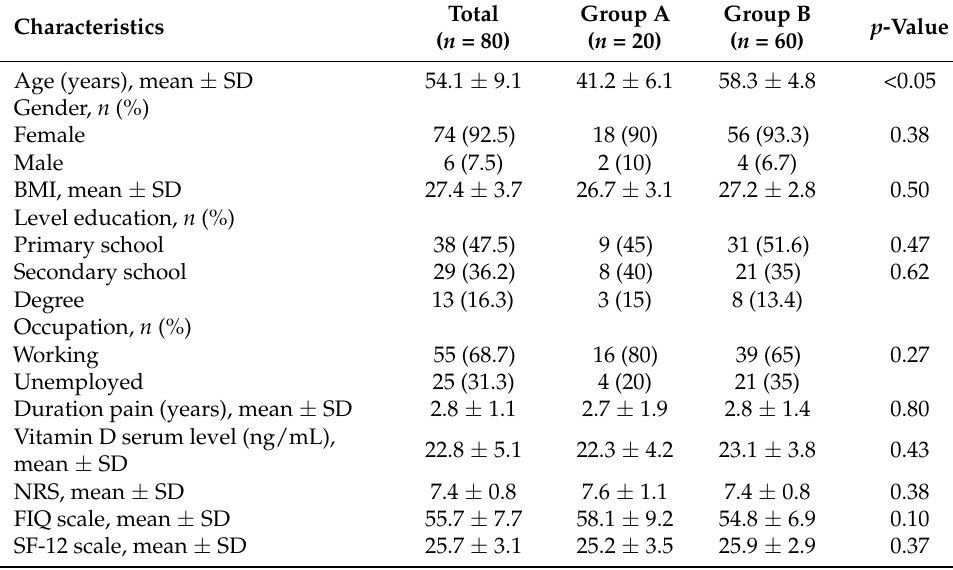
Table 1. General characteristics of patients at baseline.